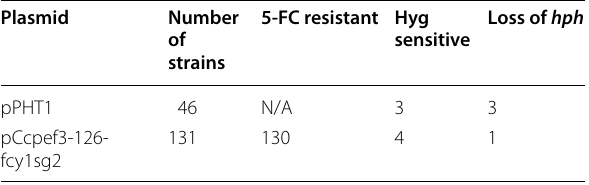
Table 3 Results of the transient transformation using hph -based plasmid Plasmid Number